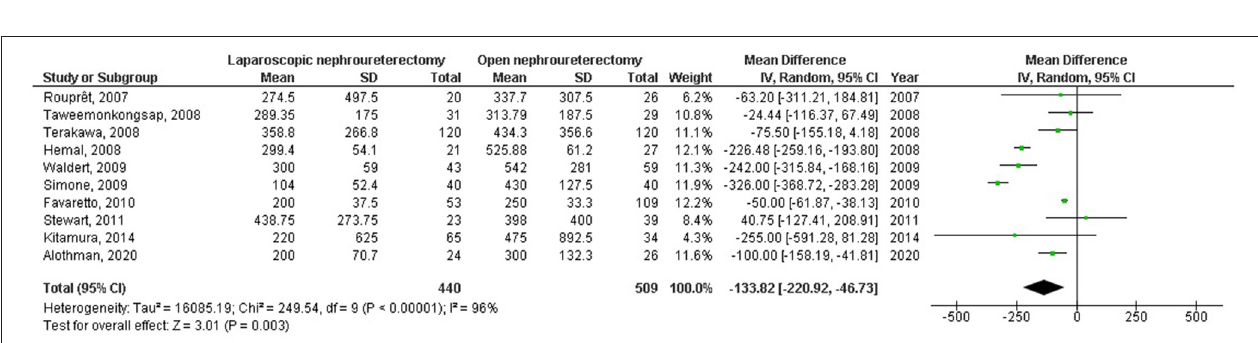
FIGURE 5 | Forest plot of the effect of open nephroureterectomy compared with laparoscopic nephroureterectomy on transfusion need in subjects with upper urinary tract urothelial carcinoma.